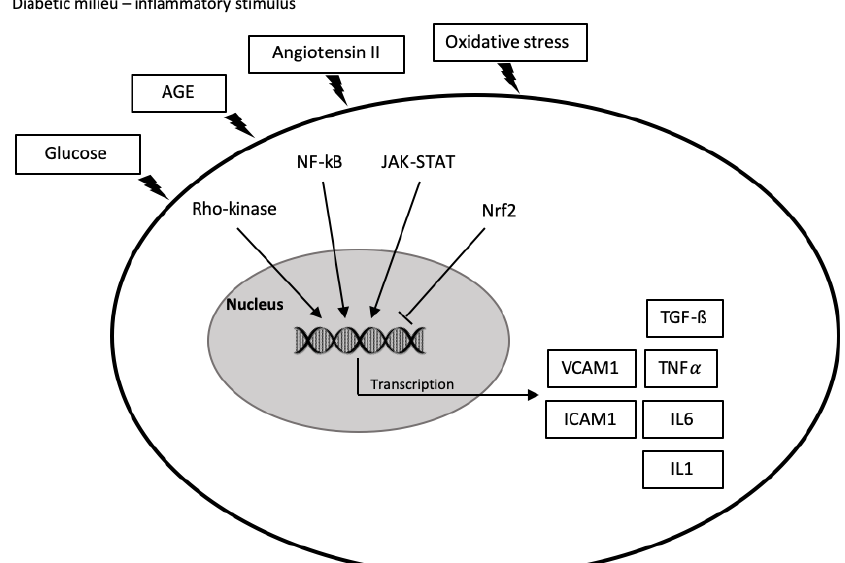
Figure 1. Overview of the participation of inflammatory mechanisms in the pathophysiology of diabetic nephropathy. In the diabetic milieu, glucose, advanced glycation end products (AGEs), angiotensin II, and oxidative stress activate a variety of signaling cascades leading the production of chemokines and cytokines that drive monocyte infiltration and the development of inflammation. AGE, advanced glycation end product; nuclear transcription factor kappa B (NF κ B); JAK-STAT, Janus kinase / signal transducer and activator of transcription; Nrf2, nuclear factor-2 erythroid related factor 2; VCAM1, vascular cell adhesion molecule 1; ICAM1, intercellular adhesion molecule; TGF- β , transforming growth factor beta; TNF, tumor necrosis factor alpha; IL,